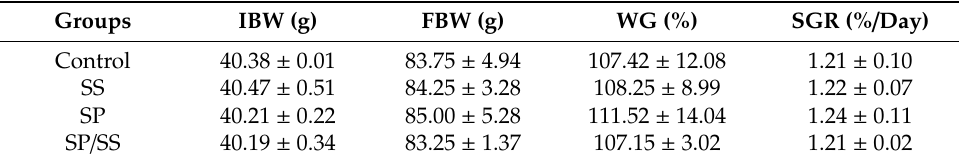
Table 3. The growth performance of Nile tilapia fed dietary Spirulina platensis (SP) with or without sodium sulphate (SS)